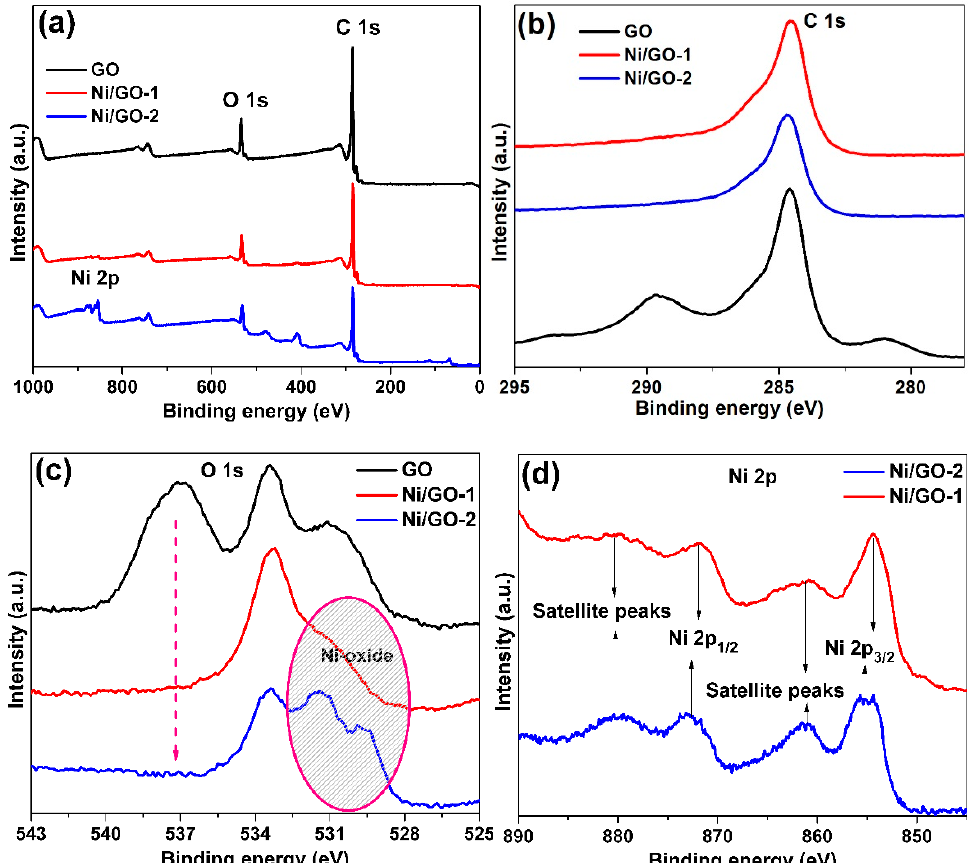
Figure 7. XPS spectra of GO, Ni / GO-1 and Ni / GO-2; ( a ) survey spectra, ( b ) C 1s peak, ( c ) O 1s peak and ( d ) Ni 2p peaks.